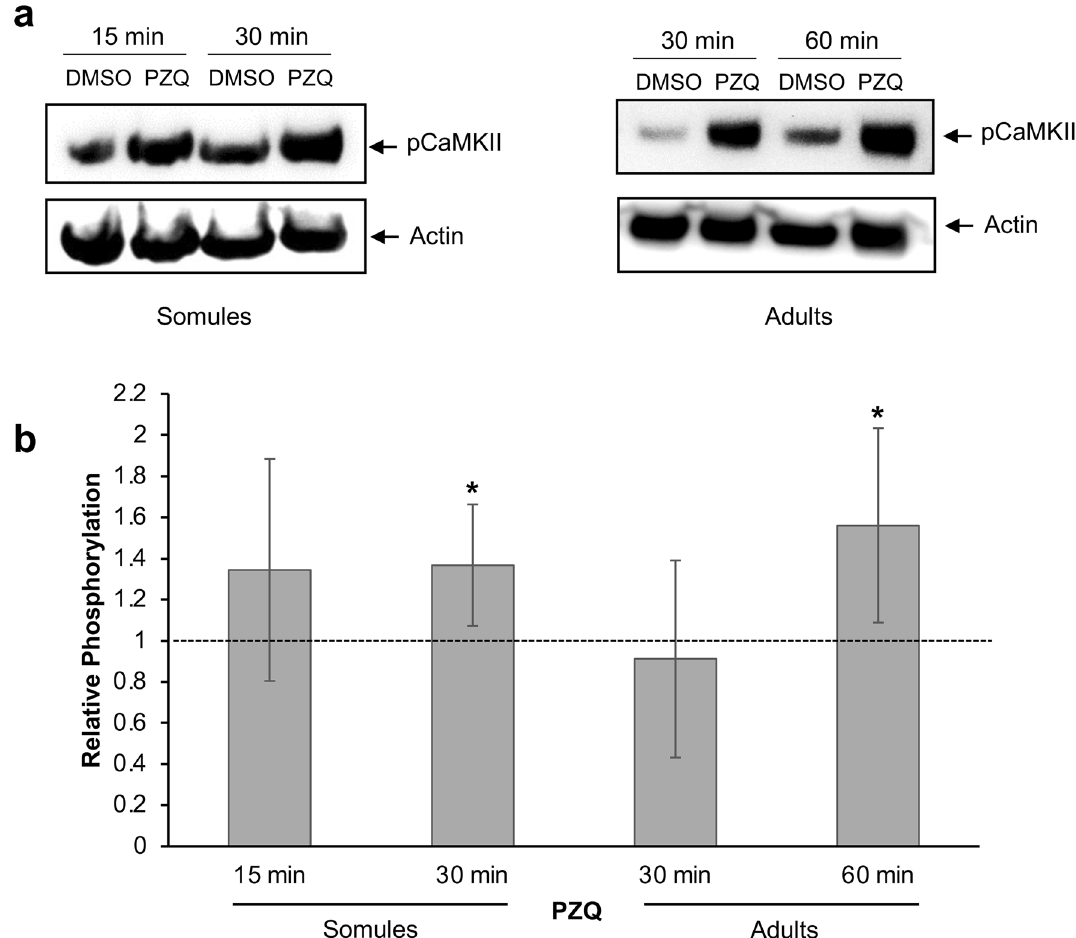
Figure 3. Praziquantel (PZQ) stimulates CaMKII phosphorylation in Schistosoma mansoni schistosomula and adults. ( a ) 24 h in vitro cultured schistosomula (~ 1000 per treatment), or ( b ) mixed male and female adult worms were exposed to PZQ (0.2 µg/ml) or DMSO (control) for increasing durations. Proteins were extracted and processed for western blotting with anti-phospho-CaMKII (Thr 286 ) antibodies; actin was used as an inter- lane loading control. Representative blots are shown. Mean CaMKII phosphorylation levels (n = 4, ± SD; graphs) were determined and phosphorylation change calculated relative to the phosphorylation levels of DMSO controls that were assigned a value of 1 (shown as dotted line); * p ≤ 0.05 (ANOVA) when compared with control